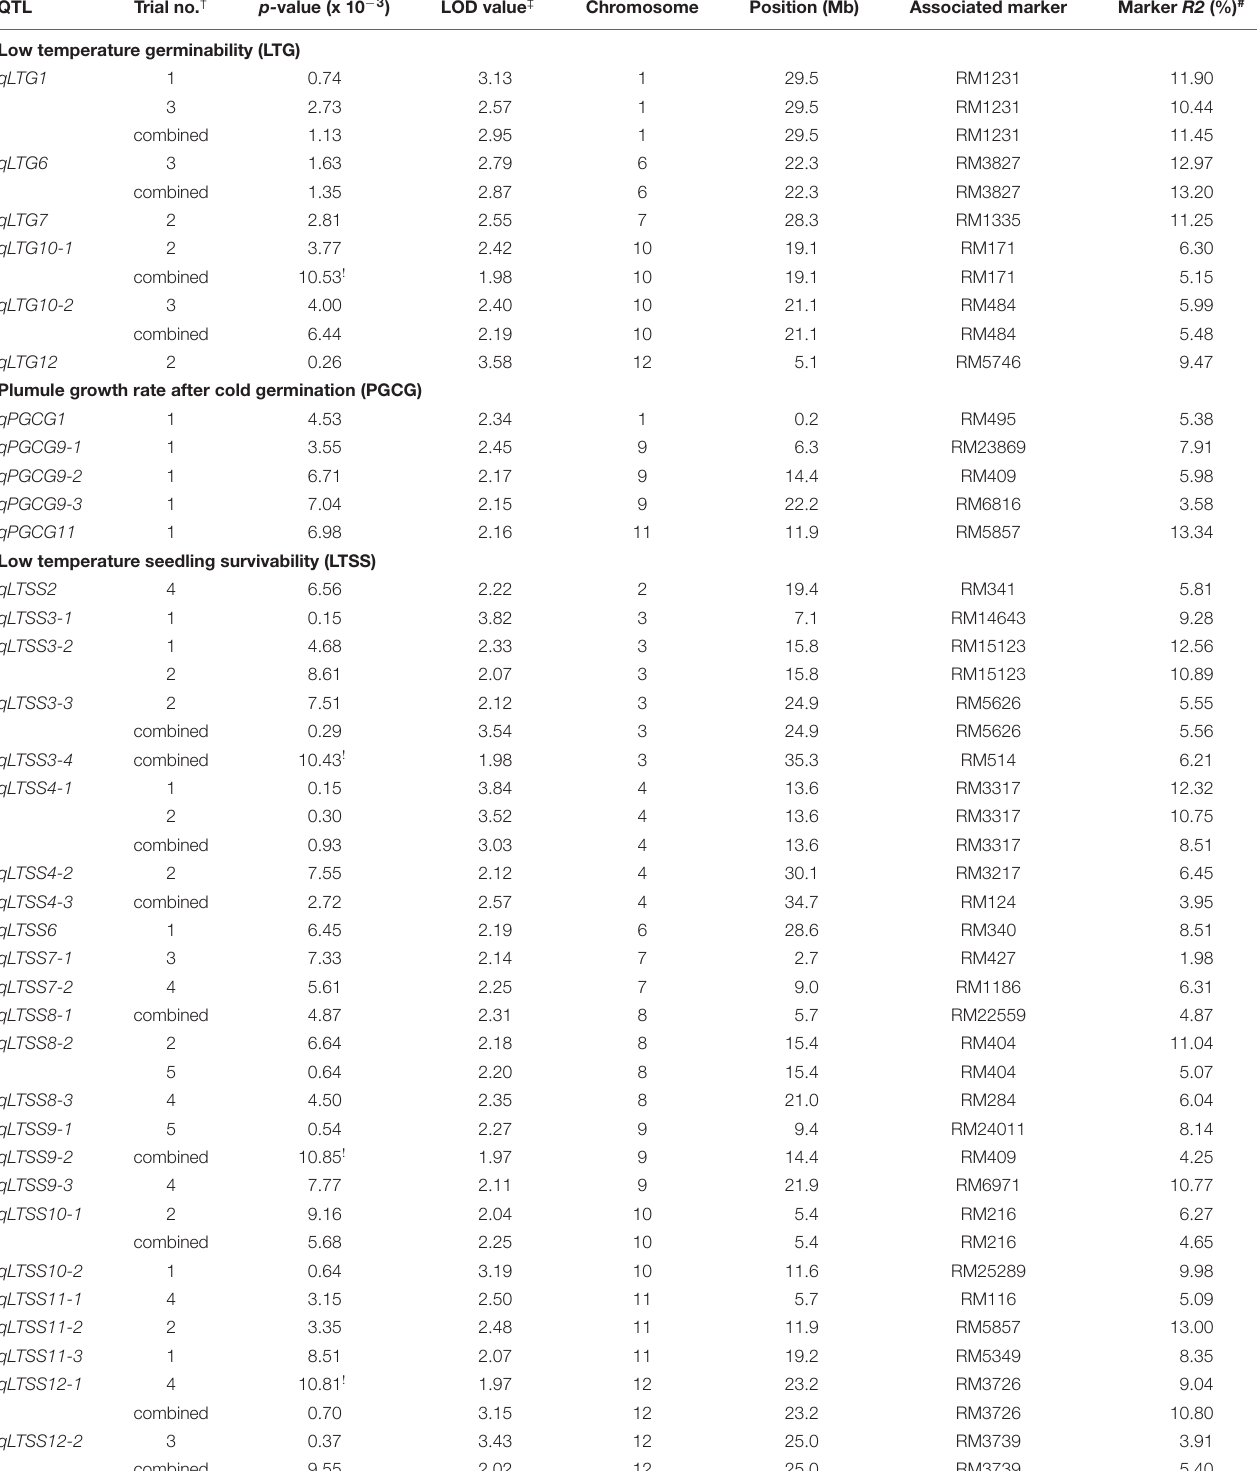
TABLE 3 | Summary of the QTL identified by GWAS mapping for five different rice seedling chilling tolerance indices. QTL Trial no. † p- value (x 10 − 3 ) LOD value ‡ Chromosome Position (Mb) Marker R2 (%)